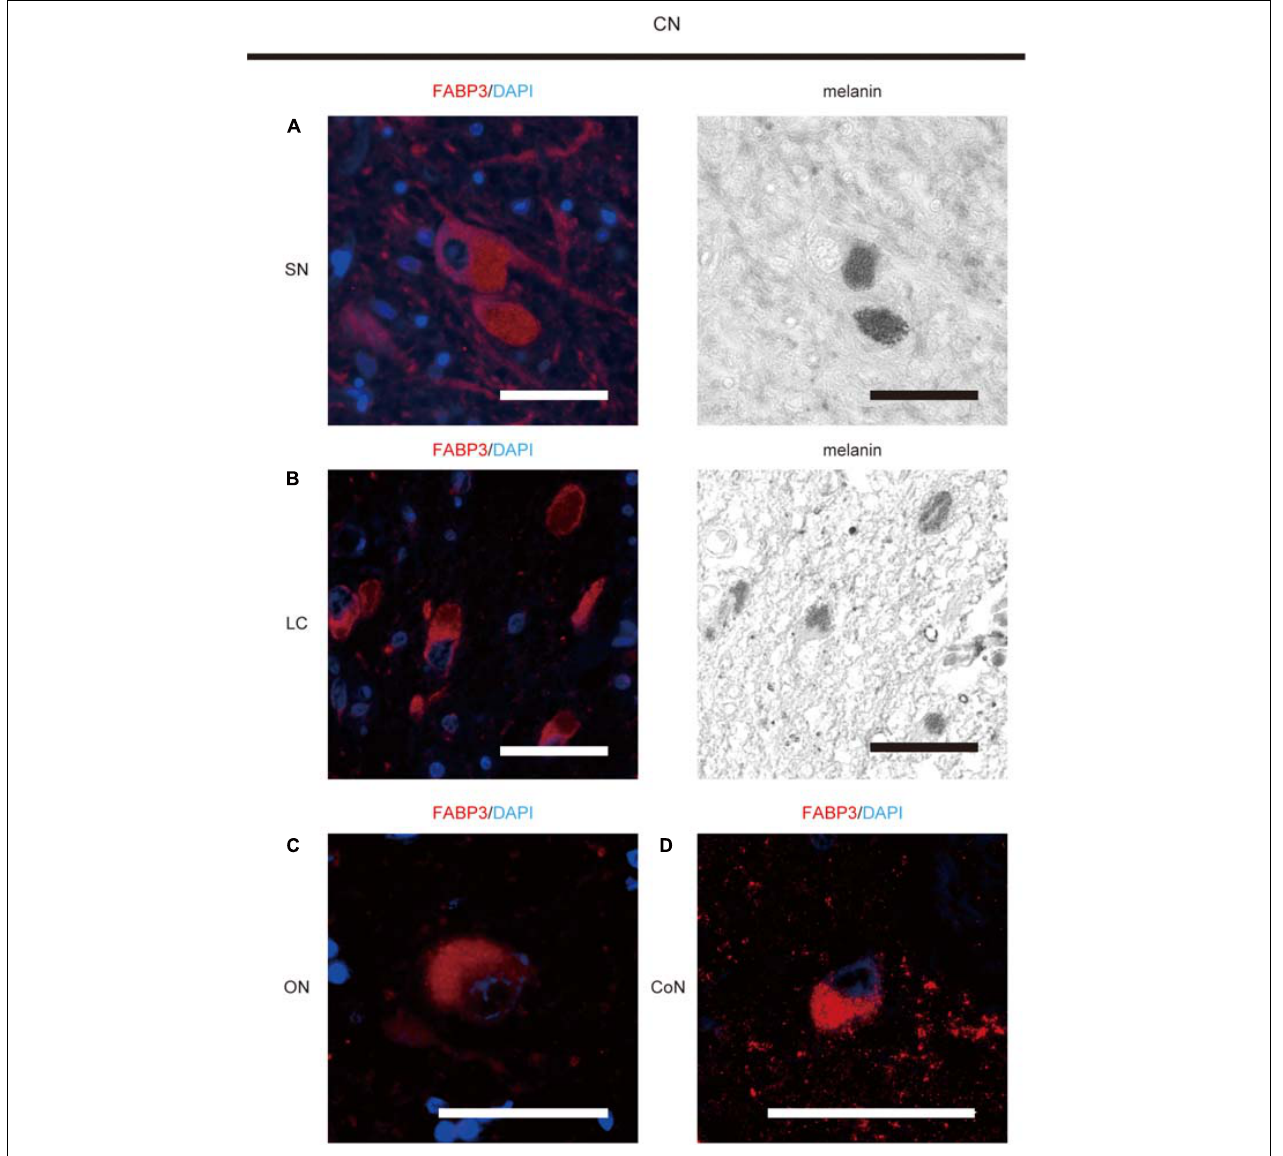
FIGURE 1 | Immunohistochemical analysis of FABP3 protein expression in autopsied brain tissues of CNs. We used fluorescence microscopy to show FABP3 expression and optical microscopy to identify melanin-positive DA neurons and locus coeruleus (LC) neurons. The nuclei of neurons were identified morphologically by DAPI (blue) staining. IF staining of FABP3 (red) and melanin (black) in DA neurons in the SN of CNs is shown in high-magnification images (A) . IF staining of FABP3 (red) and melanin (black) in LC neurons in the pons of CNs is shown in high-magnification images (B) . IF staining of FABP3 (red) in the oculomotor neurons (ON) of CNs is shown in high-magnification images (C) . IF staining of FABP3 (red) in the cortical neurons (CoN) in the EC of CNs is shown in high-magnification images (D) . FABP3-ir proteins in melanin-positive neurons were expressed mostly in the cytoplasm. FABP3-ir proteins were also expressed in oculomotor neurons and cortical neurons other than melanin-positive neurons. Scale bars = 50 µ